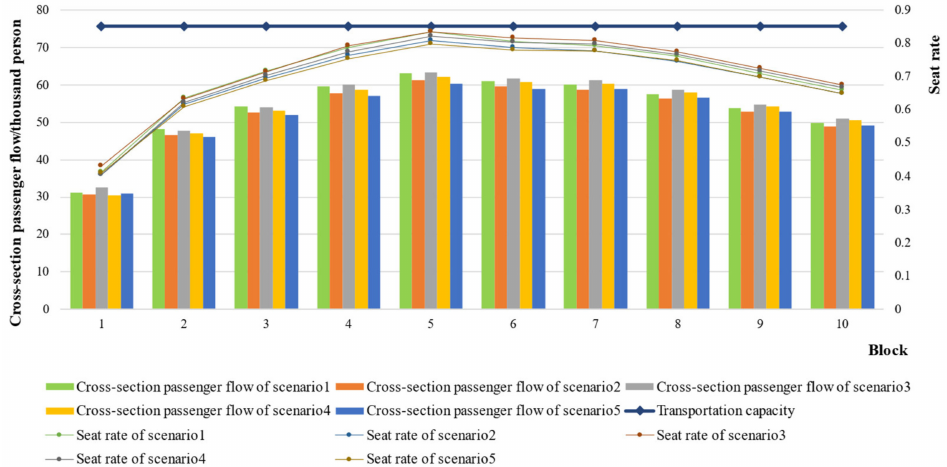
Figure 12. Transportation capacity, cross-section passenger flow, and average seat rate of each rail section under each demand